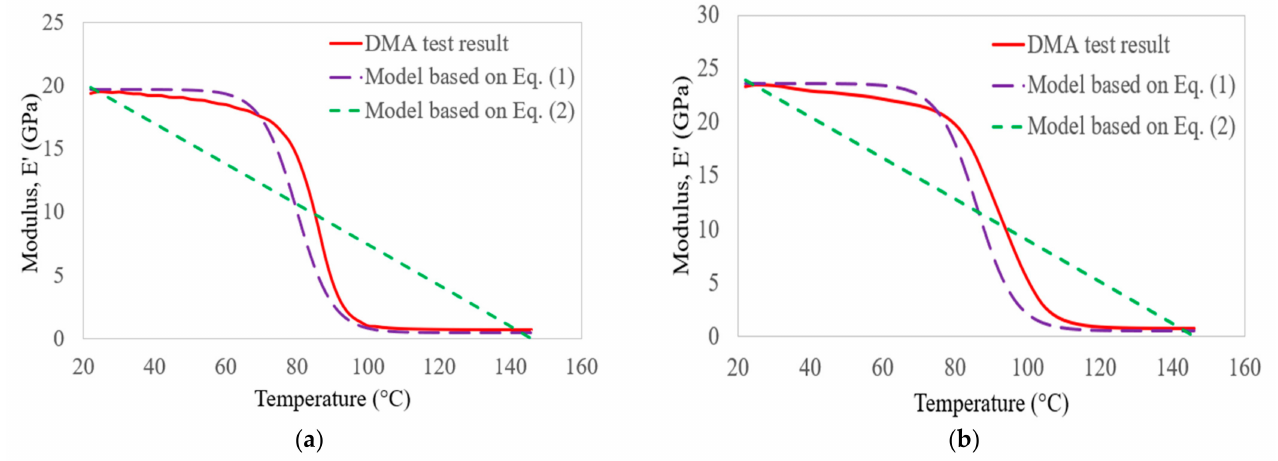
Figure 12. Comparison of glass–carbon–glass laminate storage modulus results with empirical models at 1 Hz ( a ) and 100 Hz ( b